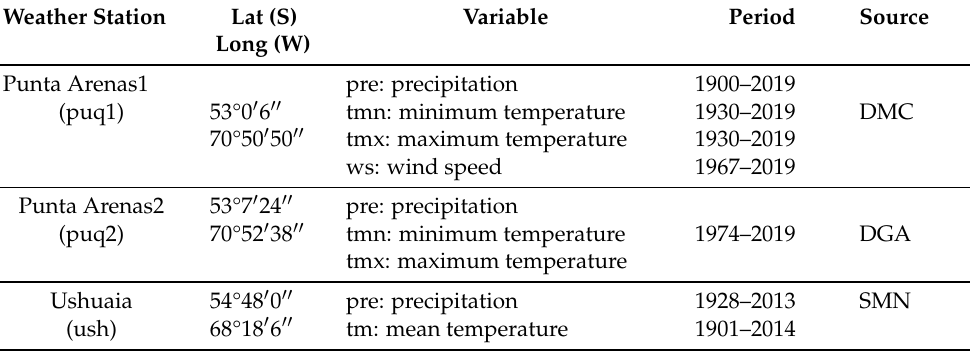
Table 2. Local climatic records and ERA5 reanalysis data used for the evaluation of proxy-climate relationships. Climate data sources: Dirección Meteorológica de Chile (DMC), Dirección General de Agua Chile (DGA), Servicio Nacional Meteorológico Argentina (SNM), and the ECMWF Reanalysis v5